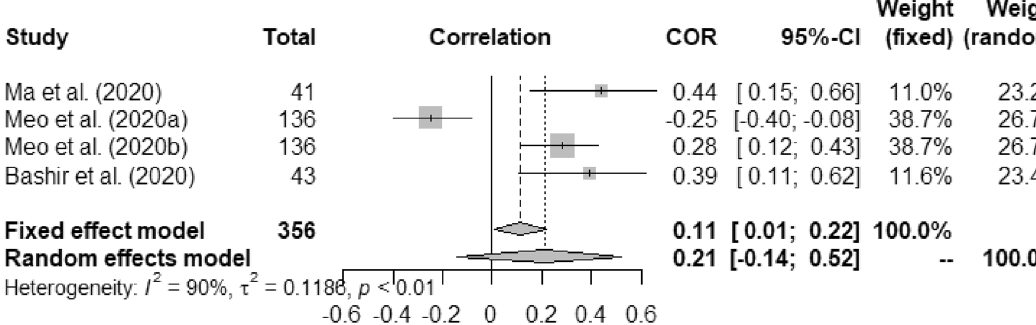
Figure 2. Forest plot of COVID-19 death rate with temperature.